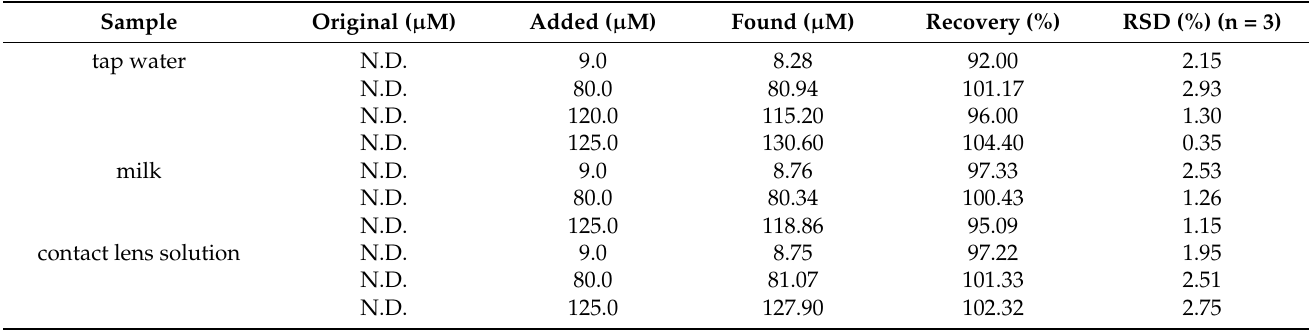
Table 2. Results of detecting H 2 O 2 in real